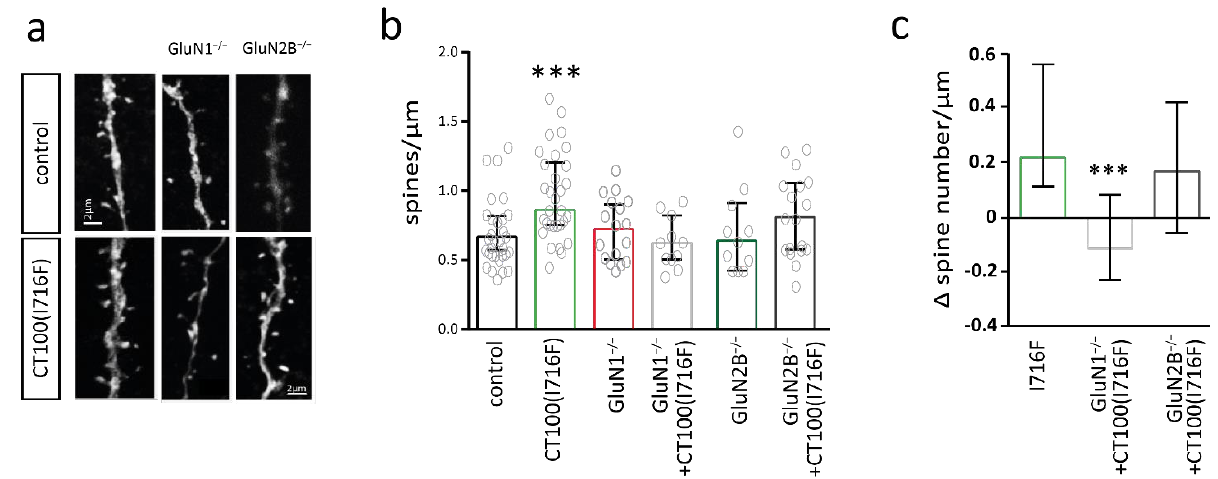
Figure 6. Increase in dendritic spine number in pyramidal cells of the somatosensory cortex of amyloid beta ( Aβ) -overex- pressing mice is mediated by the GluN1 subunit. ( a ) Sample images of dendritic spines of pyramidal cells of the soma- tosensory cortex without (control) and with CT100(I716F)-overexpression without (left) and with deletion of GluN1 (mid- dle) and GluN2B (right). ( b ) Bar graph showing the number of spines per µm of control ( n = 31) and CT100(I716F)-over- expressing ( n = 31) neurons (left) with GluN1 deletion (middle) ( n = 17 GluN1 −/− vs. n = 11 CT100(I716F)/GluN1 −/− ) or GluN2B deletion (right) ( n = 11 GluN2B −/− vs. n = 8 CT100(I716F)/GluN2B −/− ). ( c ) Bar graph showing the change in spine number in pyramidal cells from CT100(I716F)-overexpressing neurons when compared to the respective control neurons (control, GluN1 −/− , GluN2B −/− ) quantified from data in ( b ). Data in bar graphs are shown as median ± interquartile range. Empty grey circles depict single data points. t -test; Kruskal – Wallis-test: *** p < 0.001.